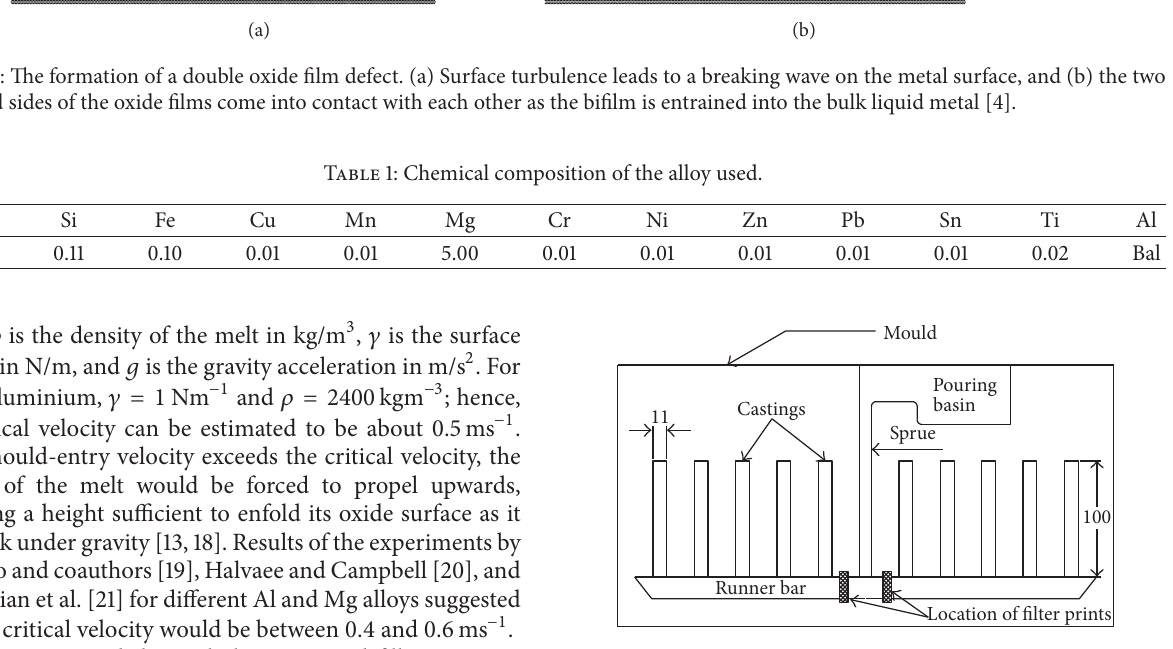
Figure 2: Shape and dimensions of the sand mould used in the experiment (dimensions are in